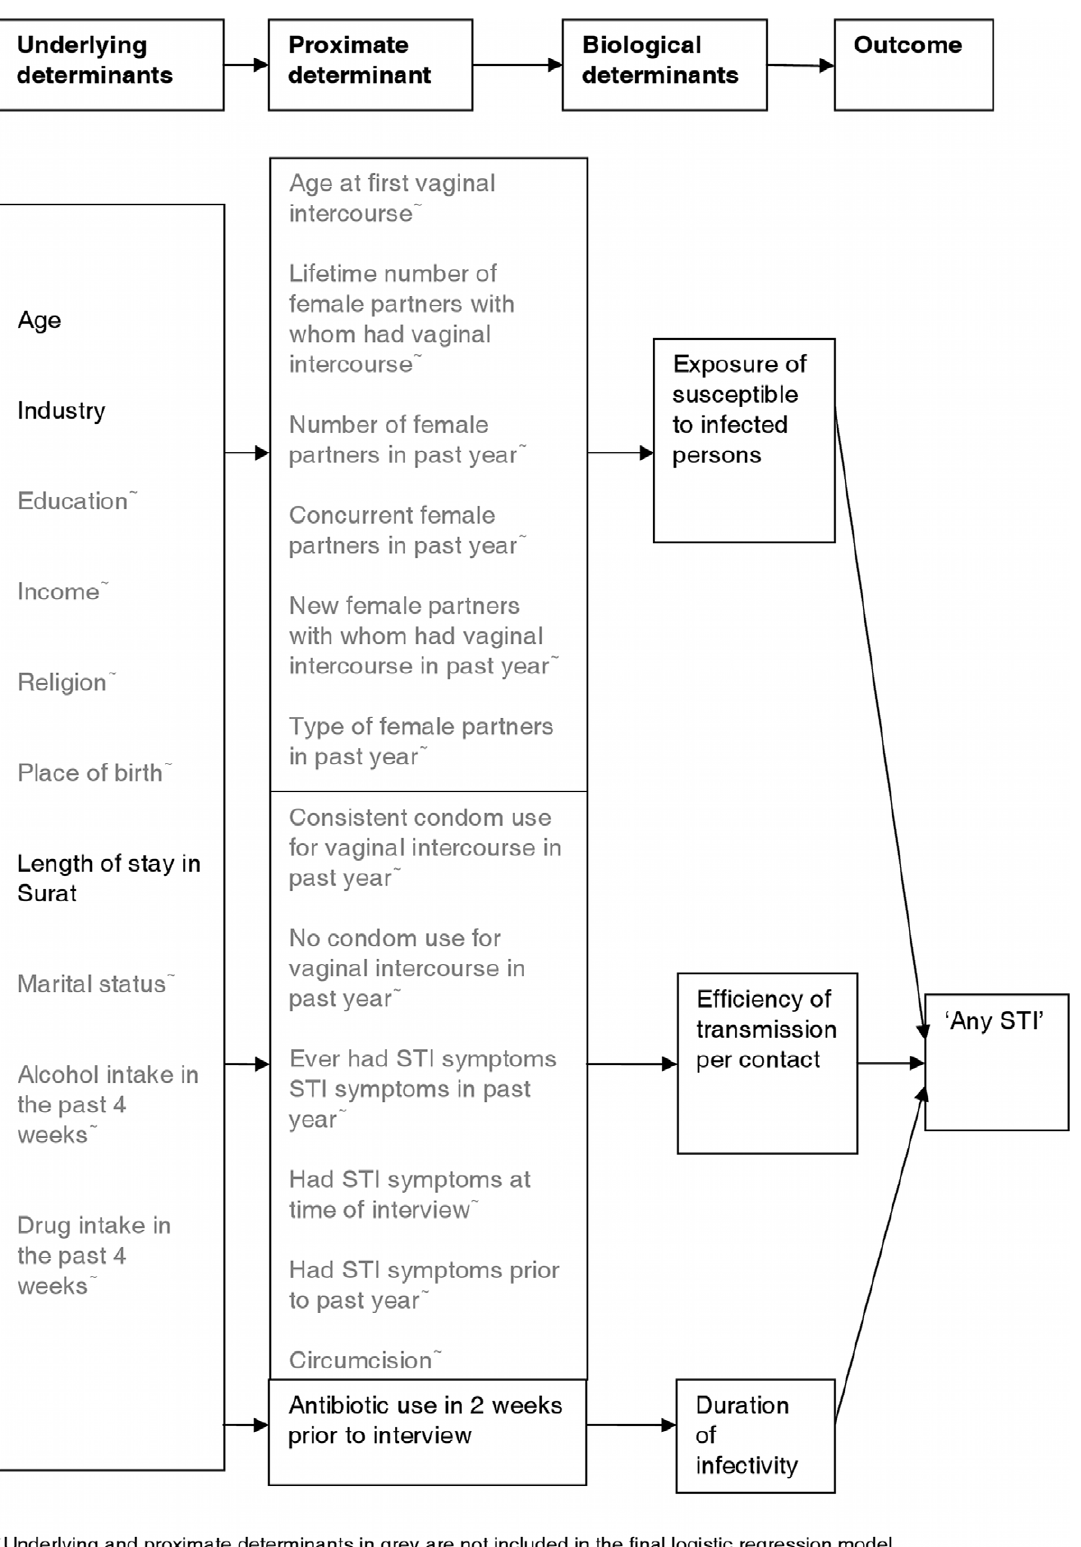
Figure 1. Final conceptual determinants model for ‘any STI’. A four level conceptual determinant model was developed for any prevalent STI diagnosis on the day of interview. The model is based on the relationship between the biological determinants of STI infection and their effect on STI outcomes. Ro=BcD summarises the relationship of the biological determinants of STI infection where Ro is the reproductive number of an infection defined as the average number of secondary cases which arise from a new case of infection, B is the efficiency of transmission per contact, c the